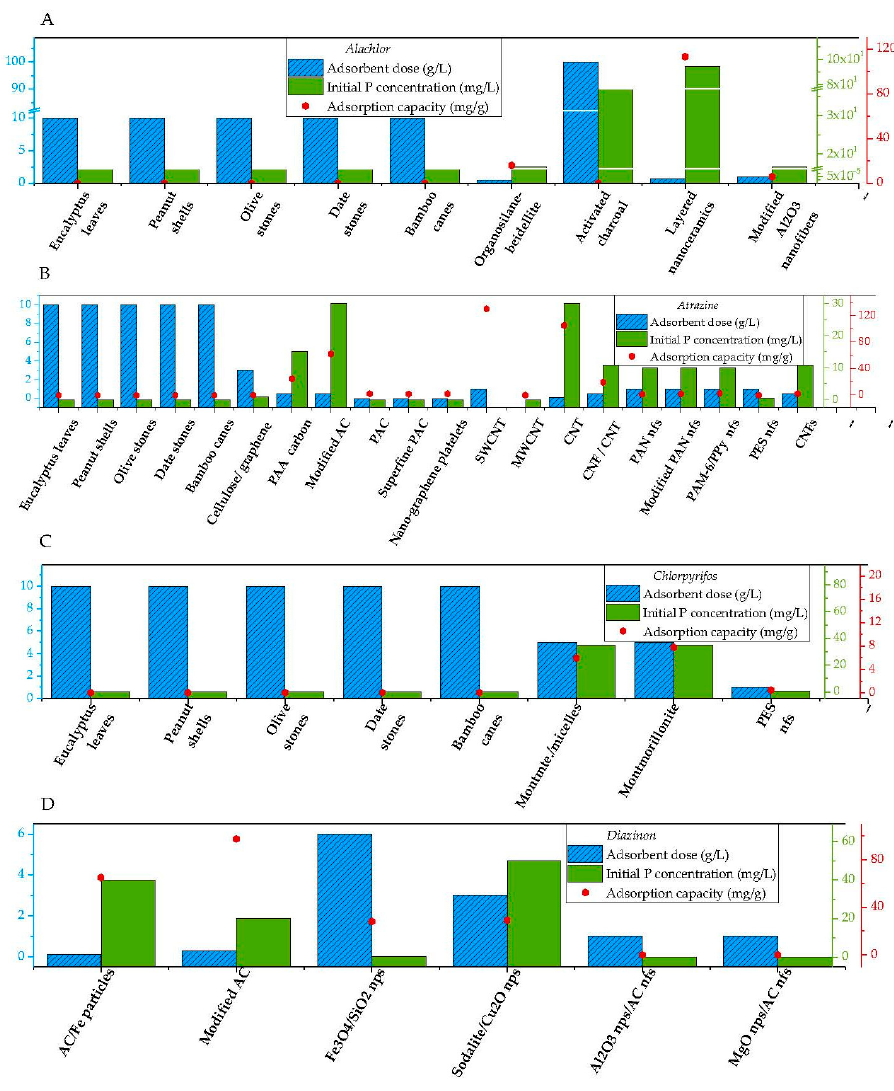
Figure 4. Relation between adsorbent dose (blue column, left scale), initial pesticide concentration (green column, middle right scale) and adsorption capacity (red scatter, far left scale) in the adsorption of Alachlor ( A ); Atrazine ( B ); Chlorpyrifos ( C ) and Diazinon ( D ).